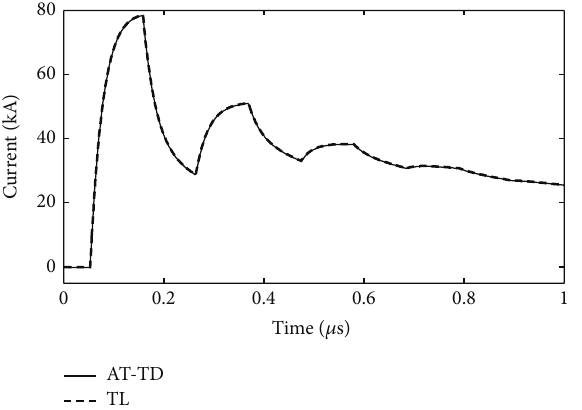
Figure 8: Transient current at the centre of the electrode: 𝐿 = 10 m, 𝜎 = 1 mS/m, and 0.1/1 𝜇 s pulse.